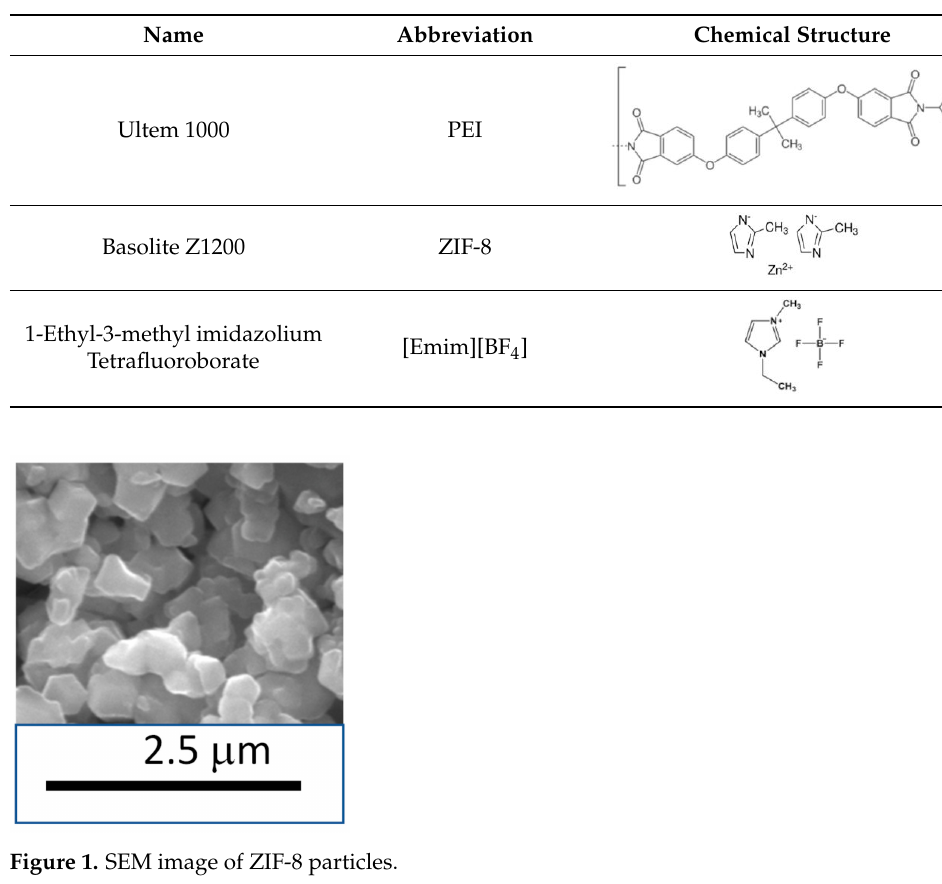
Table 1. Chemical structure of the base materials used for two-component and three-component membranes.